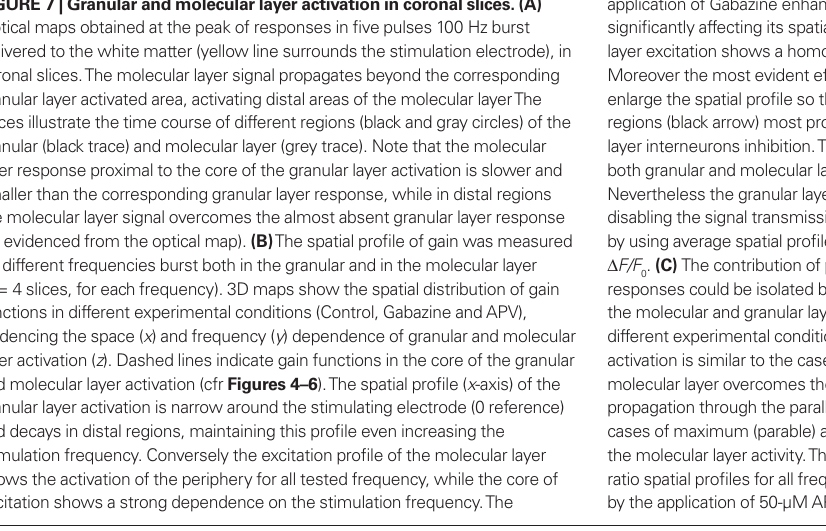
showed activation also in areas distant from the stimulation site, where no evident responses in the granular layer could be observed suggesting longitudinal transmission along the paral- lel fiber bundle.